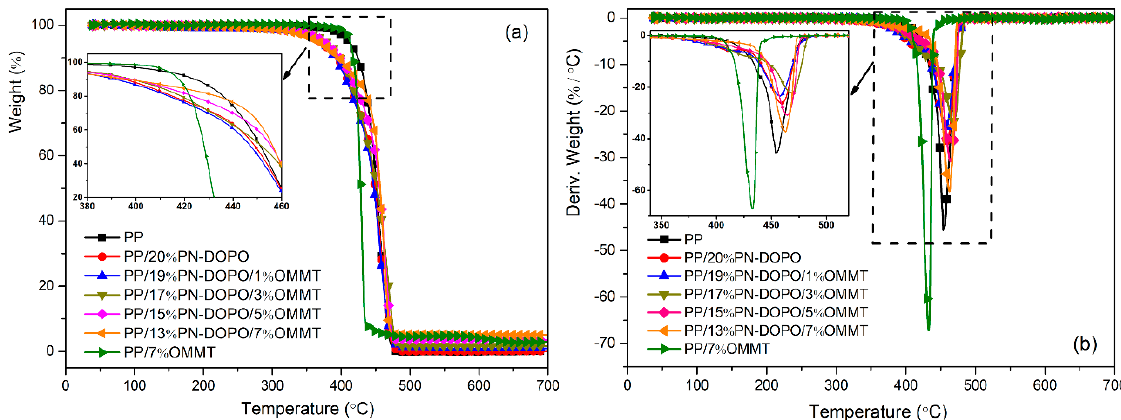
Figure 3. TGA ( a ) and DTG ( b ) curves of PP and flame-retarded PP composites in nitrogen atmosphere. Table 3. TGA and DTG data of PP and flame-retarded PP composites.